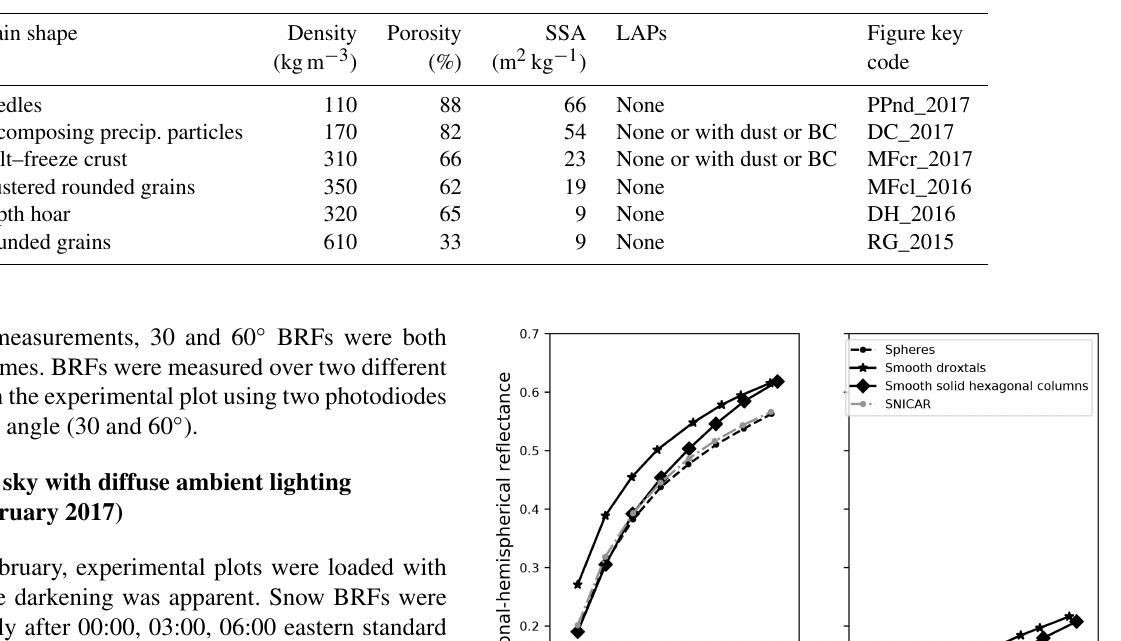
Table 2. Snow sample physical classification (Fierz et al., 2009). Snow densities, porosities, and specific surface areas (SSAs) are calculated from X-ray micro-computed tomography.